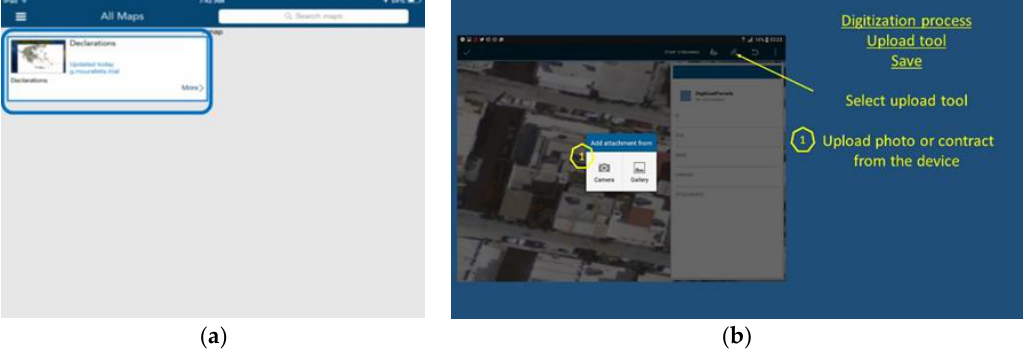
Figure 6. Indicative screenshots of the applications’ video guide. ( a ): Basemap Selection; ( b ) Digitization process - Photo upload tool.